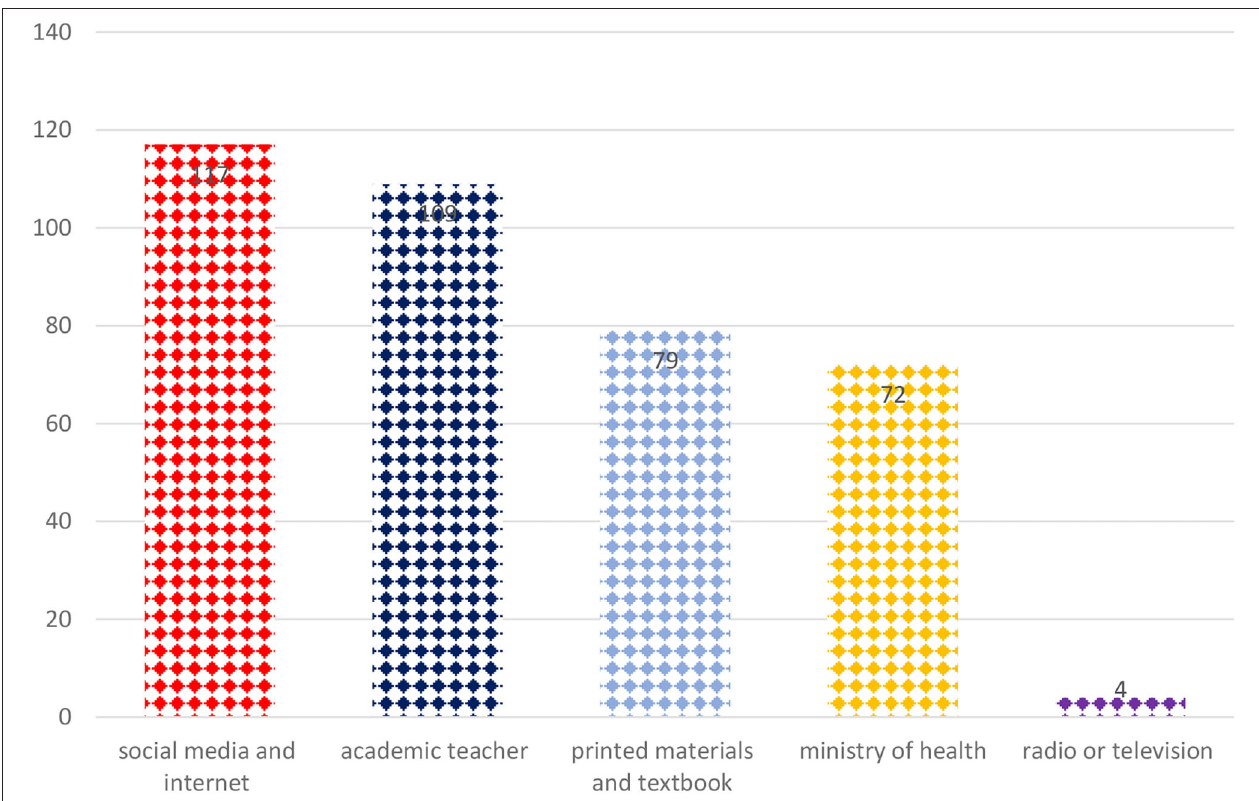
FIGURE 1 | Resources about generic